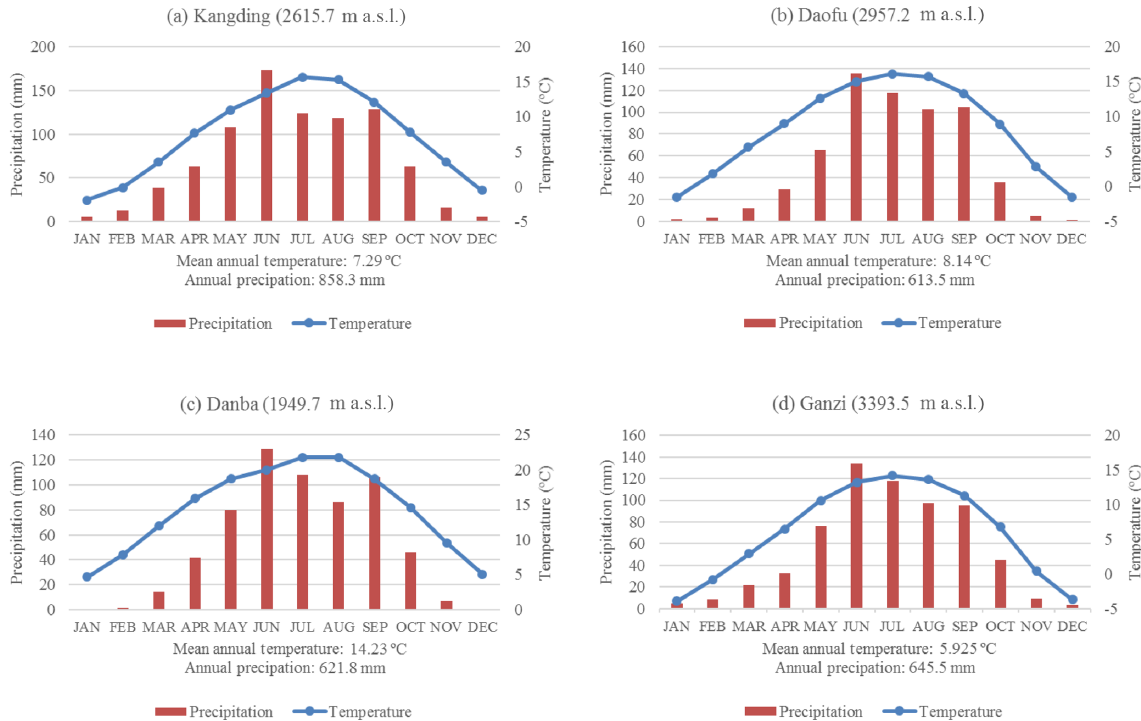
Figure 8. Climatographs for the (a) Kangding (2615.7ma.s.l., 30.03 ◦ N, 101.58 ◦ E), (b) Daofu (2957.2ma.s.l., 30.59 ◦ N, 101.07 ◦ E), (c) Danba (1949.7ma.s.l., 30.53 ◦ N, 101.53 ◦ E), and (d) Ganzi (3393.5ma.s.l., 31.37 ◦ N, 100 ◦ E) meteorological stations. Data sources: Meteorological Data Centre of the China Meteorological Administration (http://data.cma.cn/, last access: 2 June 2017, calculated for the period